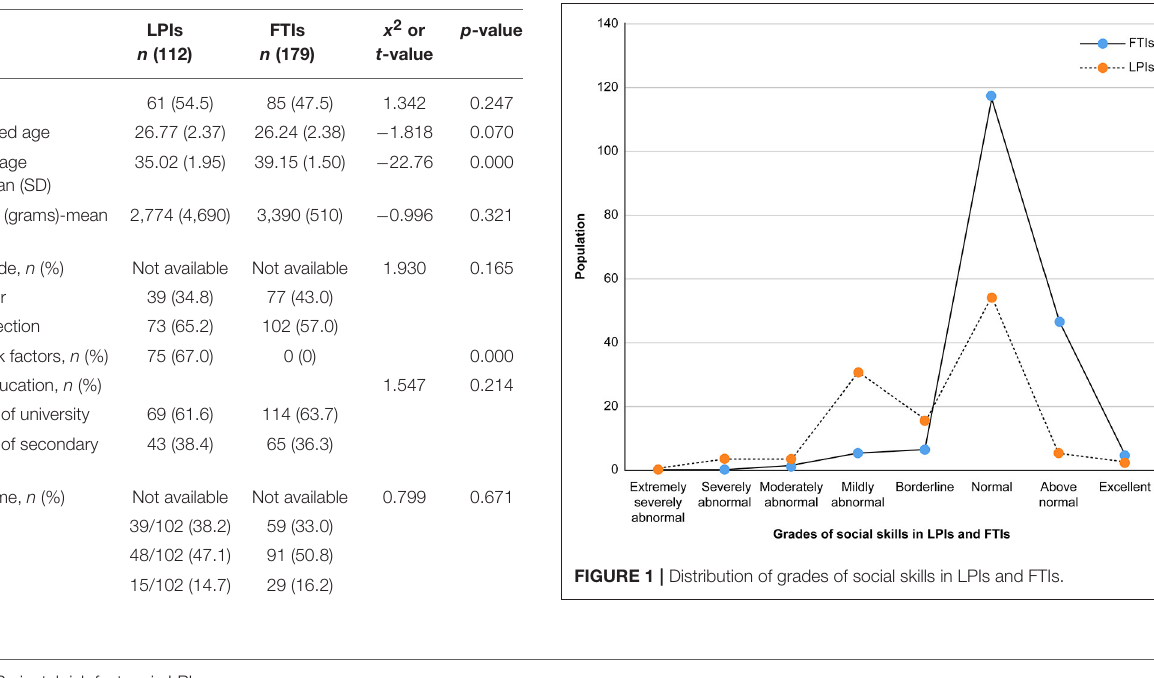
TABLE 1 | Characteristics of LPIs and FTIs.